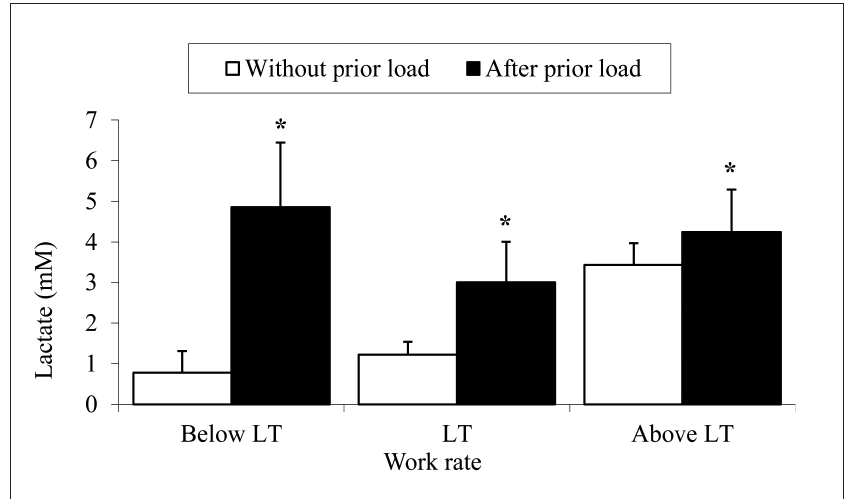
2. Mean blood lactate con - centration [La] during intermittent increasing cycling exercise on dif- ferent testing